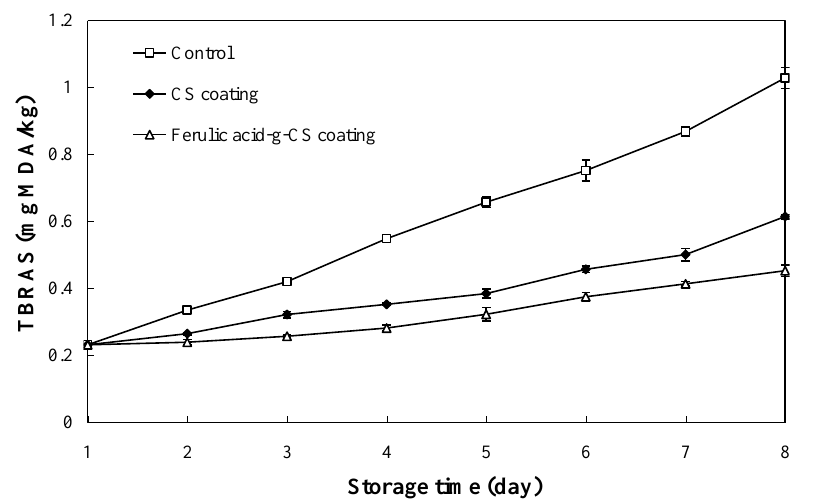
Figure 4. Changes in the TBARS value of pork in the control group, CS coating group and ferulic acid-g-CS coating group at 4 °C for 8 days. Data are presented as means ± SD of triplicates.